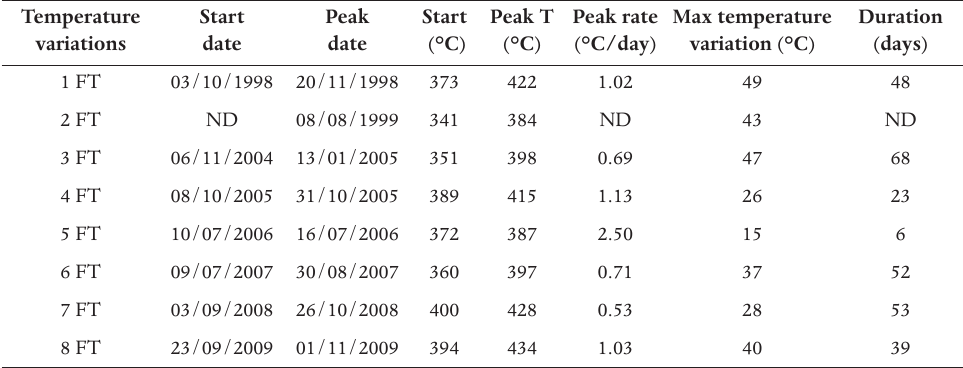
Table 1. Temperature peaks from the fumarole vent F5AT. The peaks are labeled according to Figure 7b.